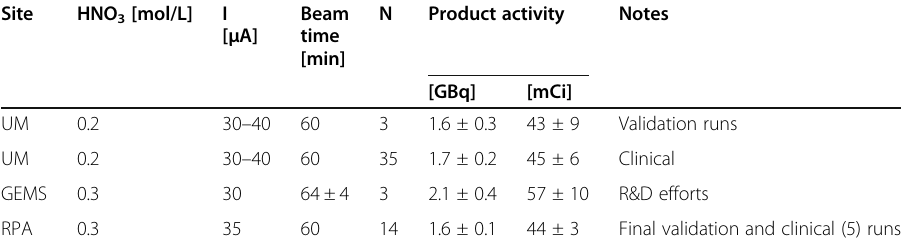
Table 6 Overview of [ 68 Ga]Ga-PSMA-11 productions (EOS)